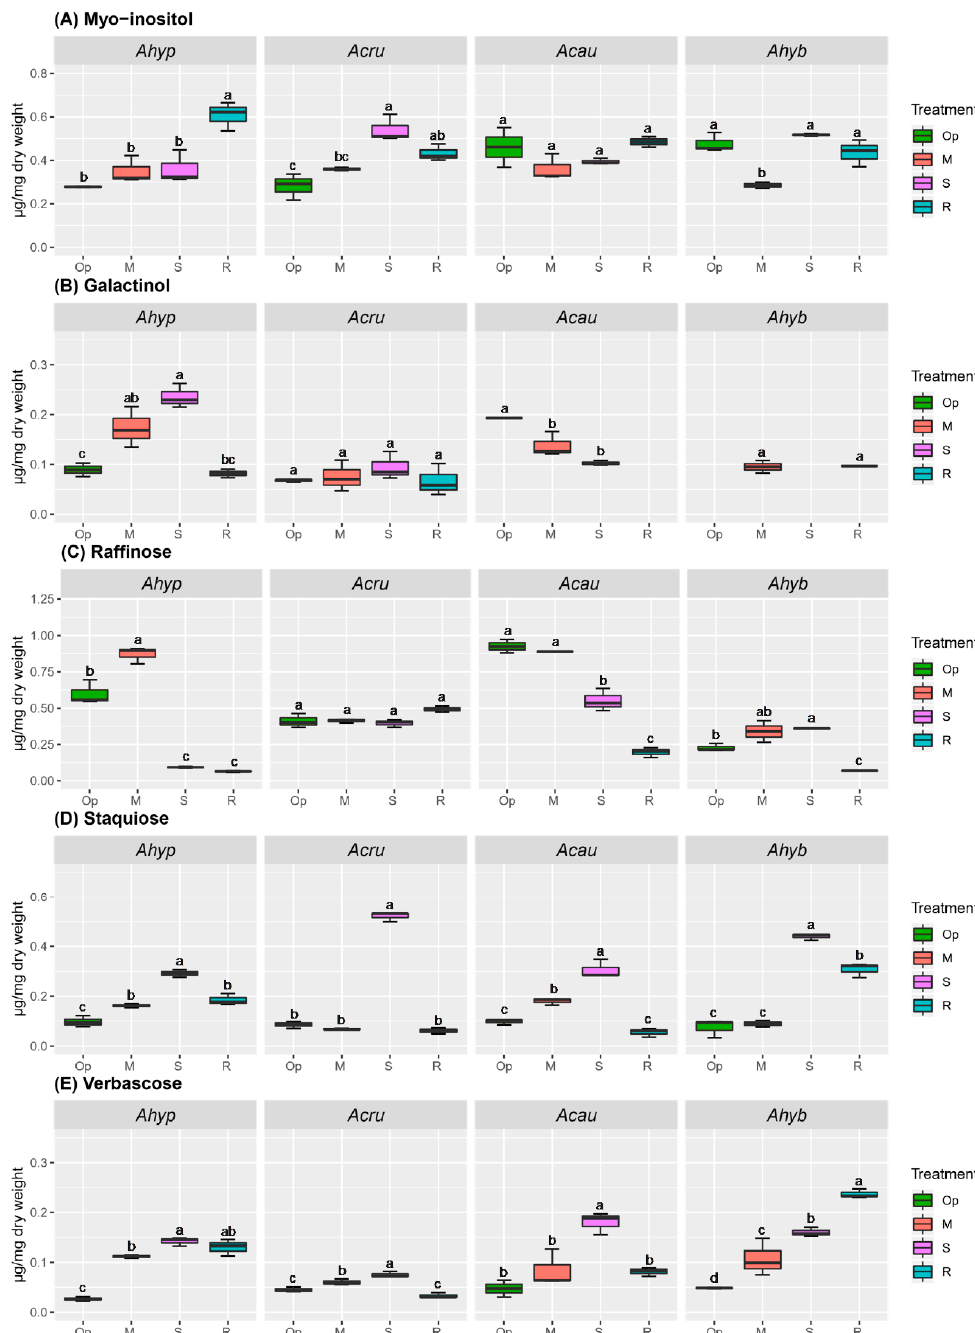
Figure 8. Raffinose family oligosaccharides (RFOs) in roots of amaranth plants subjected to water- deficit stress. RFOs in roots of Amaranthus hypochondriacus (Ahypo), A. cruentus (Acru), A. caudatus (Acau), and A. hybridus (Ahyb) plants growing in optimal conditions (Op), subjected to moderate (M) or severe (S) water deficit stress, or allowed to recover from S, 1 day after normal watering was restored (R). RFOs and RFO precursors analyzed were: ( A ) Myo-inositol; ( B ) galactinol; ( C ) raffinose; ( D ) staquiose; and ( E ) verbascose. Different letters over the box-and-whisker plots represent statistically significant differences at p ≤ 0.05 (Tukey Kramer test; n = 9). Box-and-whisker plots show high, low, and median values. The results shown are those obtained from a representative experiment that was repeated in the spring-summer and summer-autumn seasons of 2015, respectively, with similar